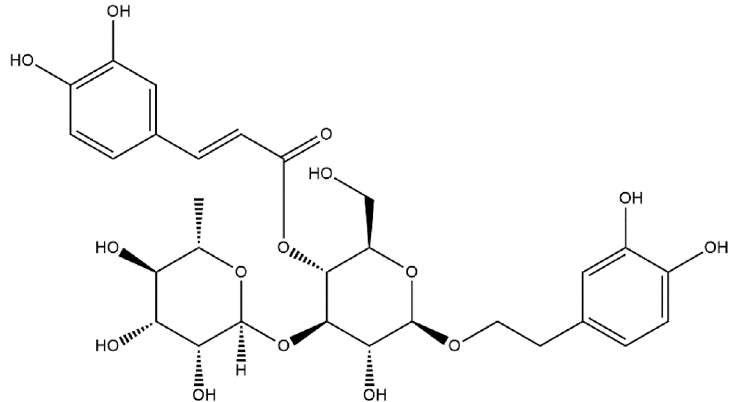
Figure 1. Structure of acteoside (Ac) from C. cyrtophyllum